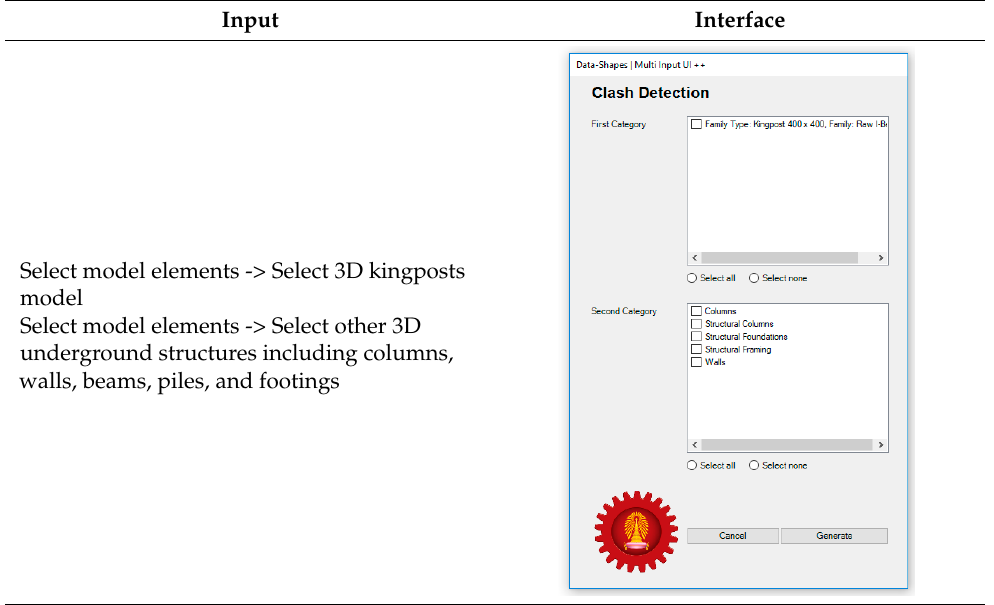
Table 8. The input and interface of clash detection.